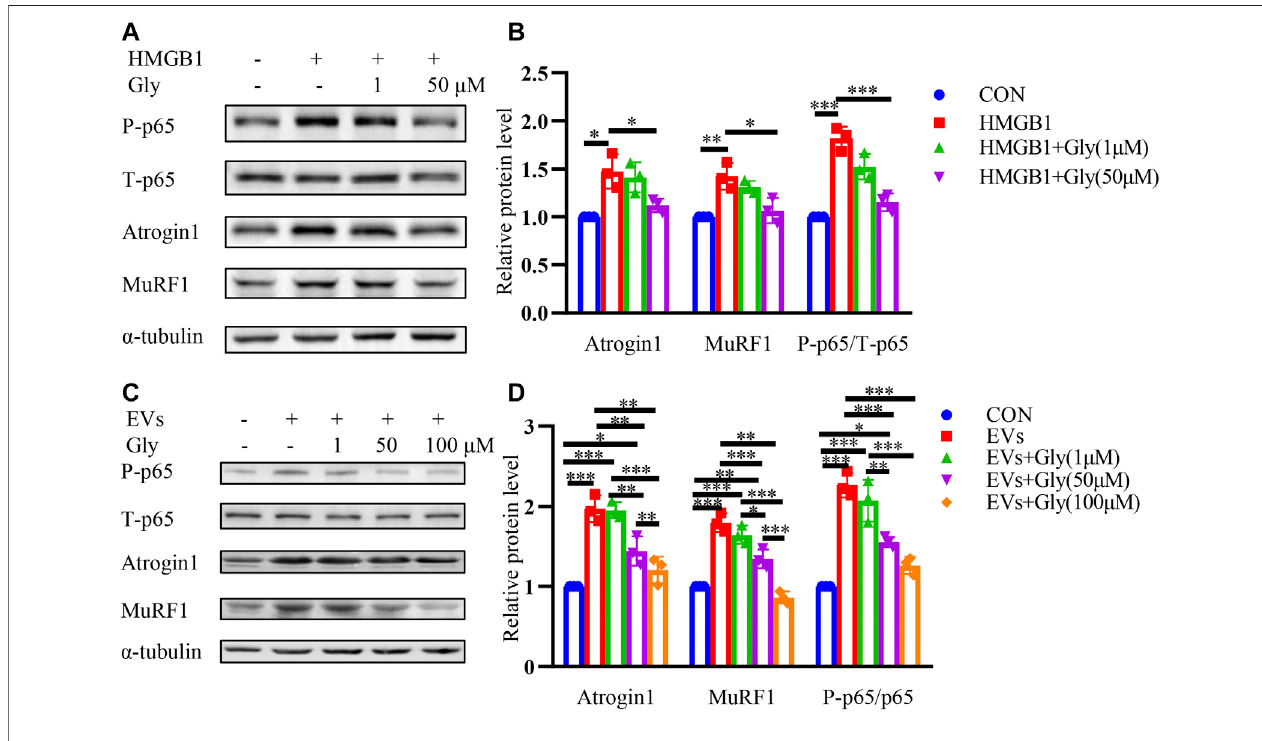
FIGURE 5 | HMGB1 inhibitor glycyrrhizin (Gly) reverses proteolysis of C2C12 myotubes induced by HMGB1 and CT26-derived exosomes. (A) Total extracts of C2C12myotubestreatedwithHMGB1,HMGB1and1 μ MGly,HMGB1and50 μ MGlywereusedforwesternblottinganalysiswithantibodiesagainstwithP-P65,P65, Atrogin1,MuRF1and α -tubulin. (B) Densitometricquanti fi cationoftheP-P65signalrelativetototalP65signalandtheAtrogin1andMuRF1signalrelativetothe α -tubulin signal. (C) TotalextractsofC2C12myotubestreatedwithEVs,EVsand1 μ MGly,EVsand50 μ MGly,EVsand100 μ MGlywereusedforwesternblottinganalysis withantibodies againstwithP-p65,P65,Atrogin1,MuRF1and α -tubulin. (D) Densitometricquanti fi cation oftheP-p65signalrelativetototalP65signaland theAtrogin1 and MuRF1 signal relative to the α -tubulin